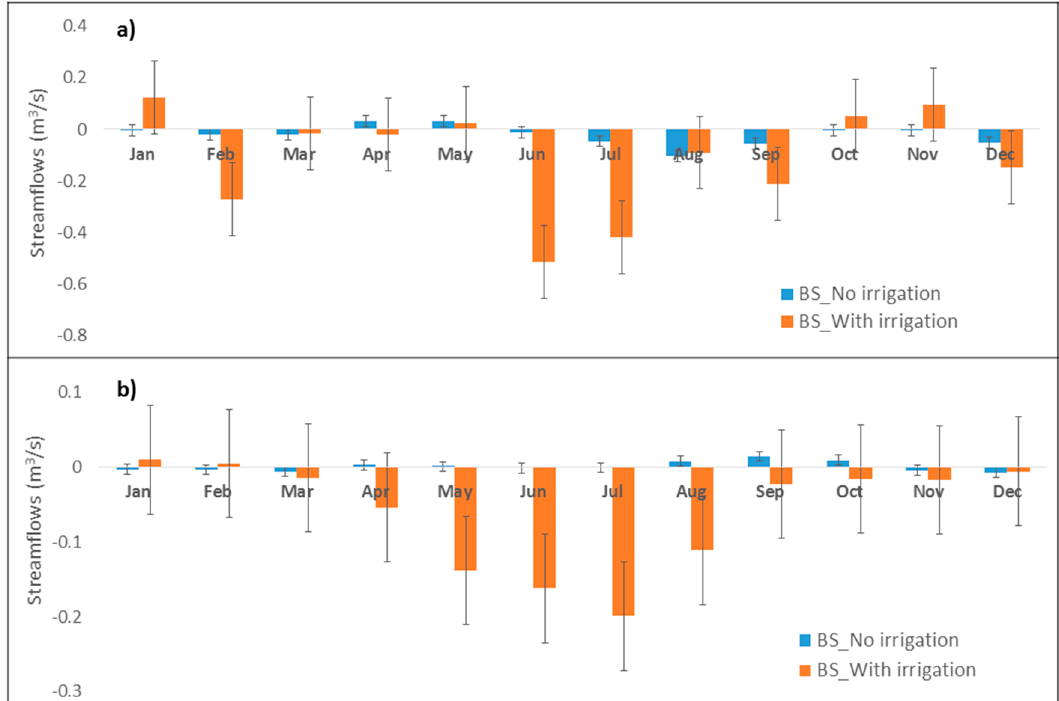
Figure 5. Changes in streamflows at Below Holland Creek ( a ) and Sixth Creek ( b ) for the scenarios with farm dams not used for irrigation (BS_No irrigation) and used for irrigation (BS_With irrigation). Error bars show one standard deviation.